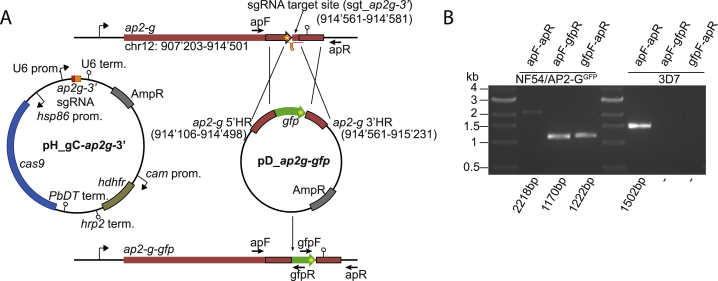
Related to Figure 4(A) Schematic maps of the endogenous ap2-g locus (PF3D7_1222600) in wild-type parasites (top), the pH_gC-ap2g-3’ and pD_ap2g-gfp transfection vectors (center), and the edited ap2-g-gfp locus after CRISPR/Cas9-based marker-free fusion of the gfp sequence to the 3’end of the ap2-g coding sequence in NF54/AP2-GGFP parasites (bottom). Numbers refer to nucleotide positions on chromosome 12 (http://plasmodb.org/). The position of the sgt_ap2g3’ sgRNA target sequence 60bp downstream of the ap2-g coding sequence is indicated. The pH_gC-ap2g-3’ Cas9/sgRNA suicide plasmid contains expression cassettes for SpCas9, the sgRNA and the hdhfr resistance marker. In the pD_ap2g-gfp donor plasmid two homology regions (5’HR and 3’HR) flanking the gfp coding sequence facilitate repair of the Cas9-induced double-strand break and marker-free tagging of the ap2-g gene by double crossover homologous recombination. Yellow asterisks indicate the position of translation termination codons. Positions of PCR primer binding sites used to confirm successful gene editing are indicated by horizontal black arrows.(B) PCR on gDNA isolated from NF54/AP2-GGFP and 3D7 wild-type control parasites. Primers apF and apR bind to wild-type sequences outside the ap2-g 5’HR and ap2-g 3’HR homology regions and amplify a 2218bp or 1502bp fragment from the edited ap2-g-gfp or wild-type ap2-g locus, respectively. The ap2F/gfpR and gfpF/ap2R primer combinations are specific for the edited ap2-g-gfp locus in NF54/AP2-GGFP parasites and amplify 1170 and 1222bp fragments, respectively.